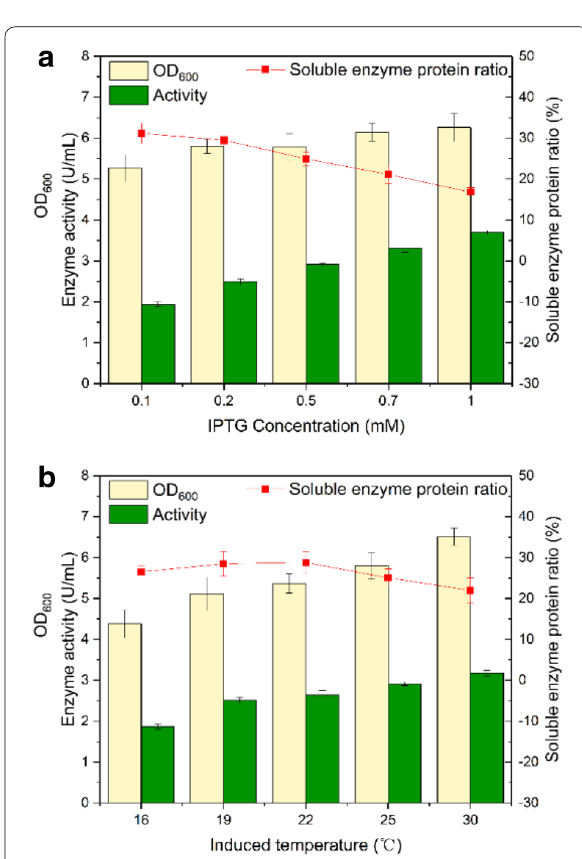
Fig. 3 Effects of induction conditions on the wild CbADH activity in shake-flask fermentation. a Induced by different IPTG concentrations (0.1–1.0 mM) at 25 ℃ . b Induced at different temperatures (16–30 ℃ ) with 0.5 mM IPTG